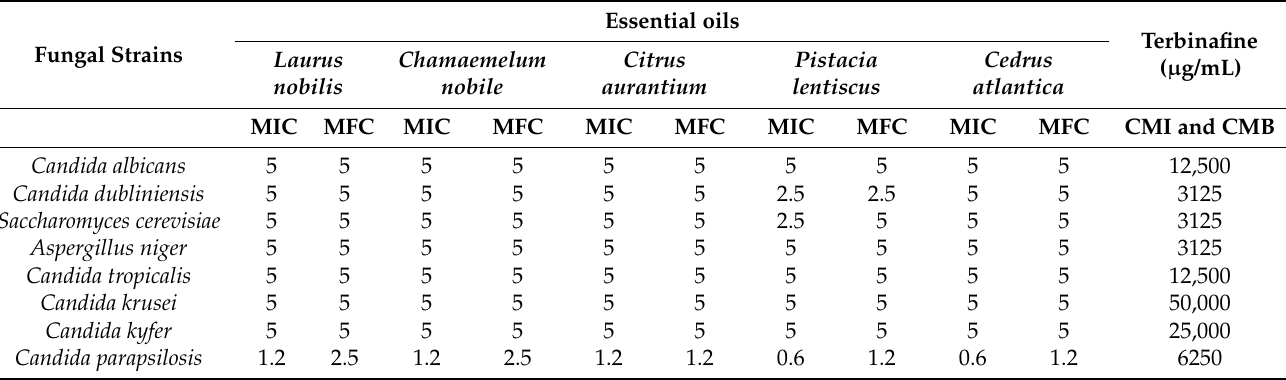
Table 15. MIC and MFC (mg/mL) of the EOs